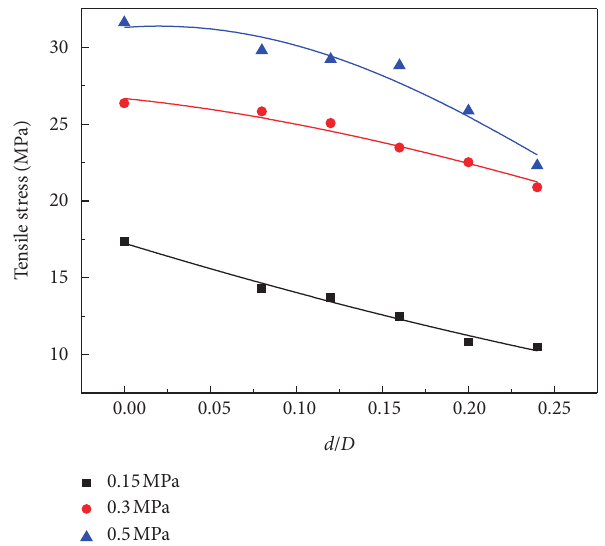
Figure 6: Relationship between dynamic tensile strength and hole diameter of